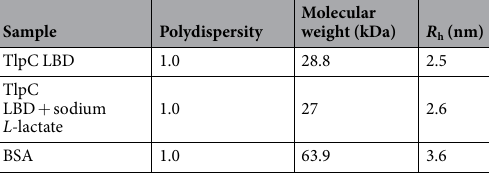
Table 4. Dynamic light-scattering